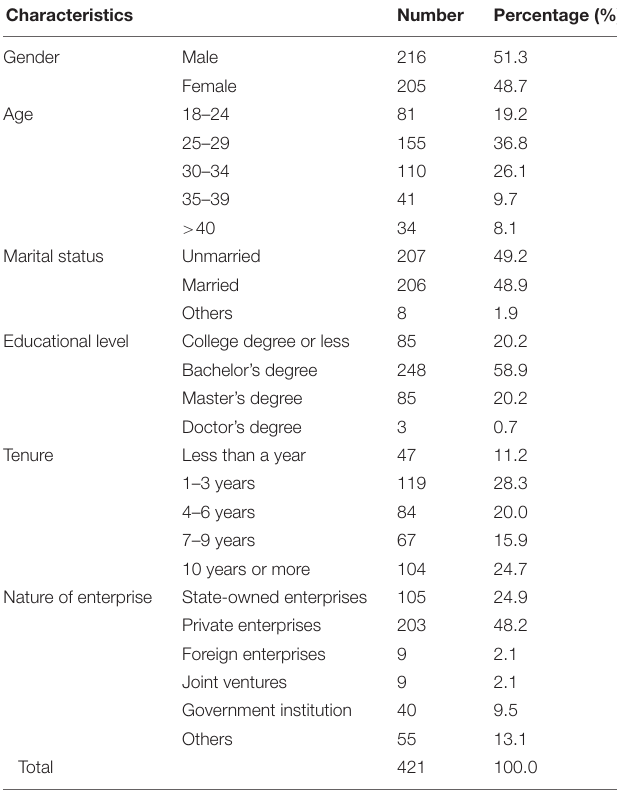
TABLE 1 | Demographics characteristics of